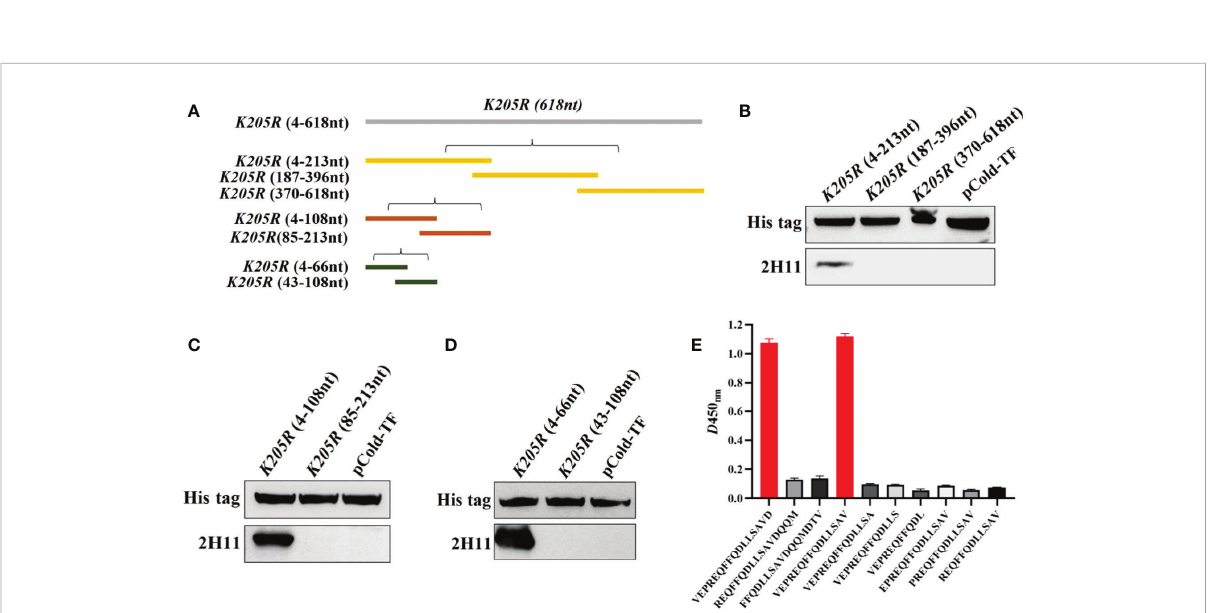
FIGURE 3 2H11 recognized speci fi c linear B-cell epitope 2 VEPREQFFQDLLSAV 16 . (A) Schematic diagram of K205R gene truncated fragments. (B-D) A series of truncated pK205R were constructed to pCold-TF and successfully expressed in E coli BL21 (DE3) cells. 2H11 was used to detect the truncated pK205R by WB using anti-His tag antibody or 2H11 as primary antibody, respectively. (E) Ten different truncated peptides were synthesized and tested by ELISA to show the minimum epitope recognized by 2H11.